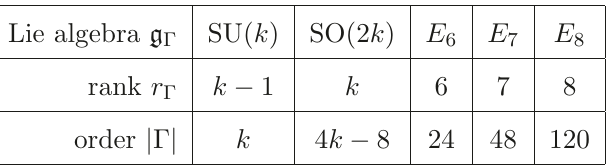
Table 1 . The rank r Γ and order